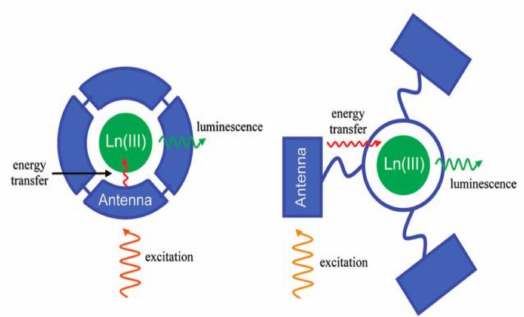
Figure 1. The antenna effect for lanthanide(III) (Ln(III)) sensitization, illustrated using the chromophoric chelate (right) and pendant chromophore (left) ligand designs. Reprinted with permission from [48]. Copyright 2009, American Chemical